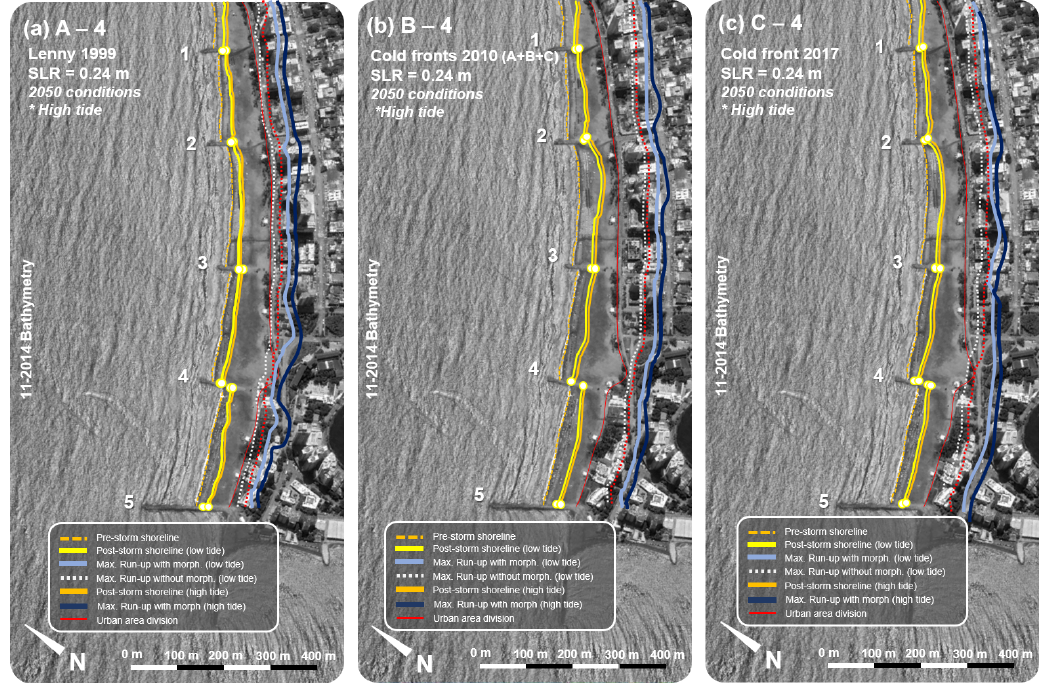
Figure 9. Maximum flood reach and post-storm shorelines simulated by XBeach at low and high tide. Map base images retrieved from © Google Earth and modified by the